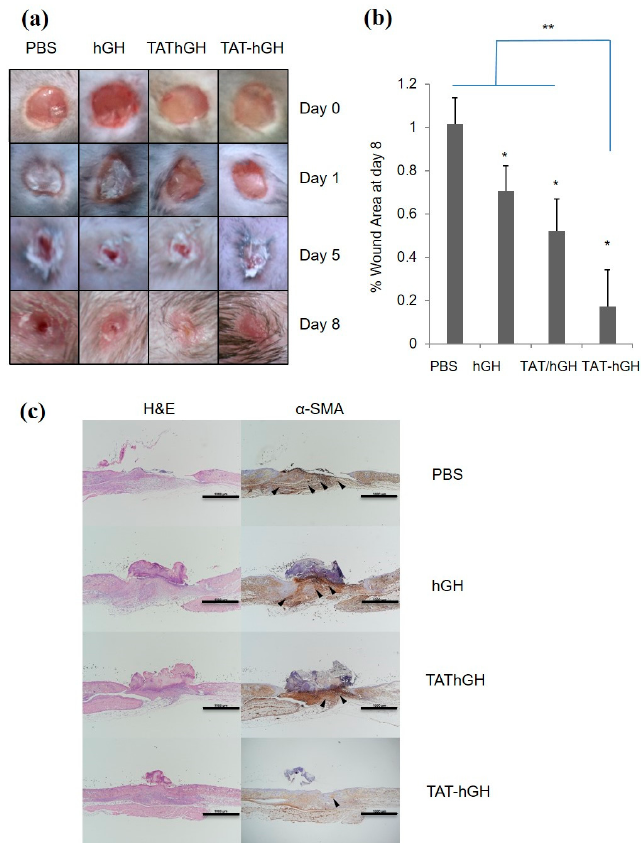
Figure 4. The effects of topical hypromellose gel treatments containing hGH, TAT/hGH, and TAT- hGH on wound re-epithelialization and tissue formation in C57BL/6 mice ( n = 4). ( a ) The morpho- logical changes in wound area over 8 days. The initial wound diameter was 4 mm; ( b ) the percentage of wound area at day 8; ( c ) representative light microscopy images of sections from the center of the wound tissue at day 8. The wound sections were stained using hematoxylin and eosin (H&E) to observe re-epithelialization, and immunohistochemical staining of α -smooth muscle actin ( α -SMA, arrowheads) to evaluate myofibroblast differentiation. Scale bars are 1000 µm. Values are presented as the mean ± standard deviation ( n = 4). * indicates p < 0.05 vs. the control (vehicle); ** indicates p < 0.01 vs. the control (vehicle).